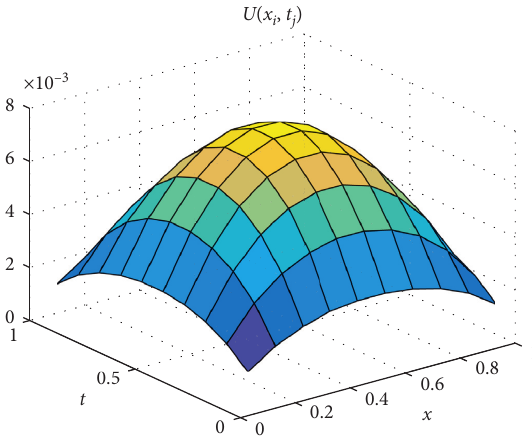
Figure 3: Approximated solution for Bratu equation with C � 0 . 1. Table 7: Abscissas and weights of Gauss Legendre quadrature formula for t �